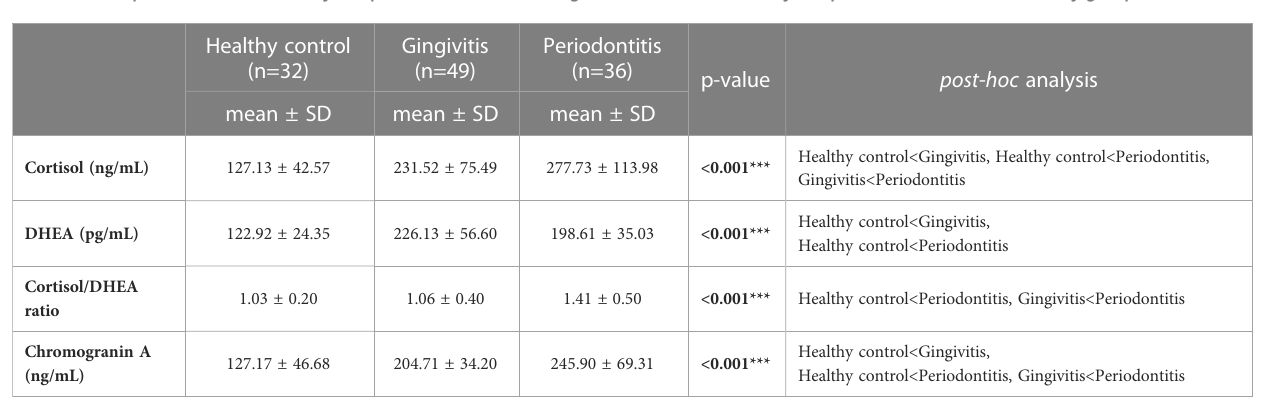
TABLE 2 Comparison of cortisol, dehydroepiandrosterone, chromogranin A, and cortisol/dehydroepiandrosterone ratio values by group.